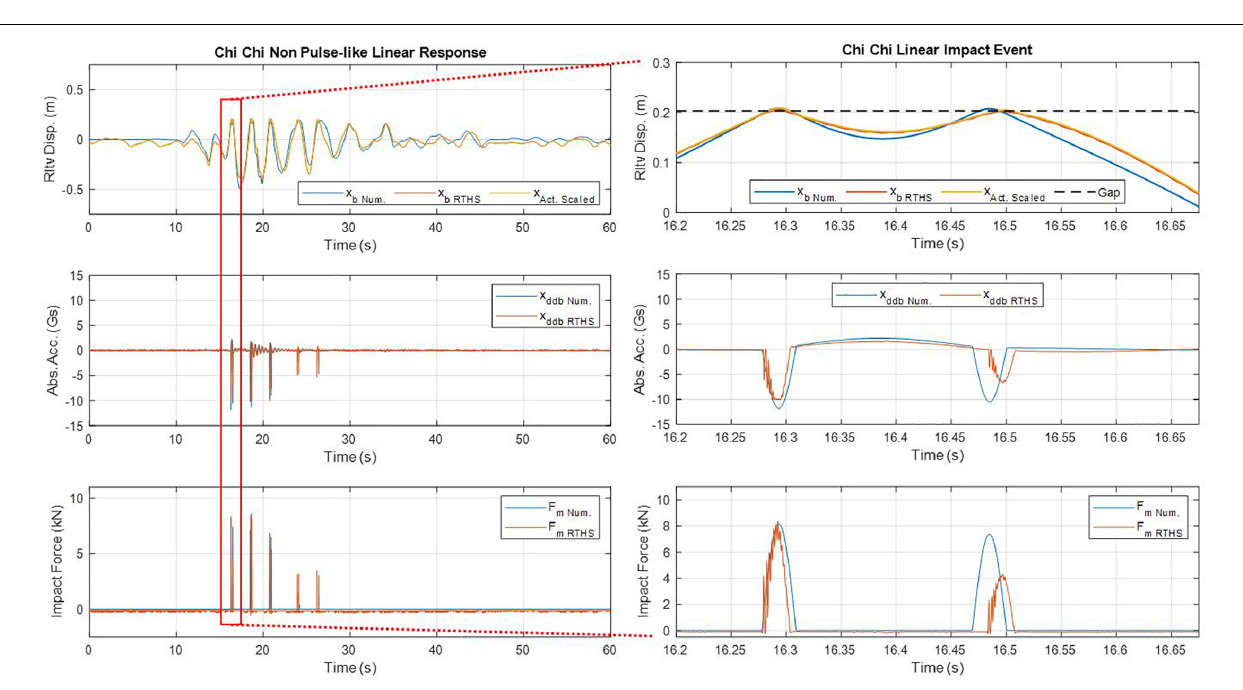
signals within the time histories were obtained during the RTHS tests of the structural response to ground motions using the physical moat wall substructure. The nonlinear response of